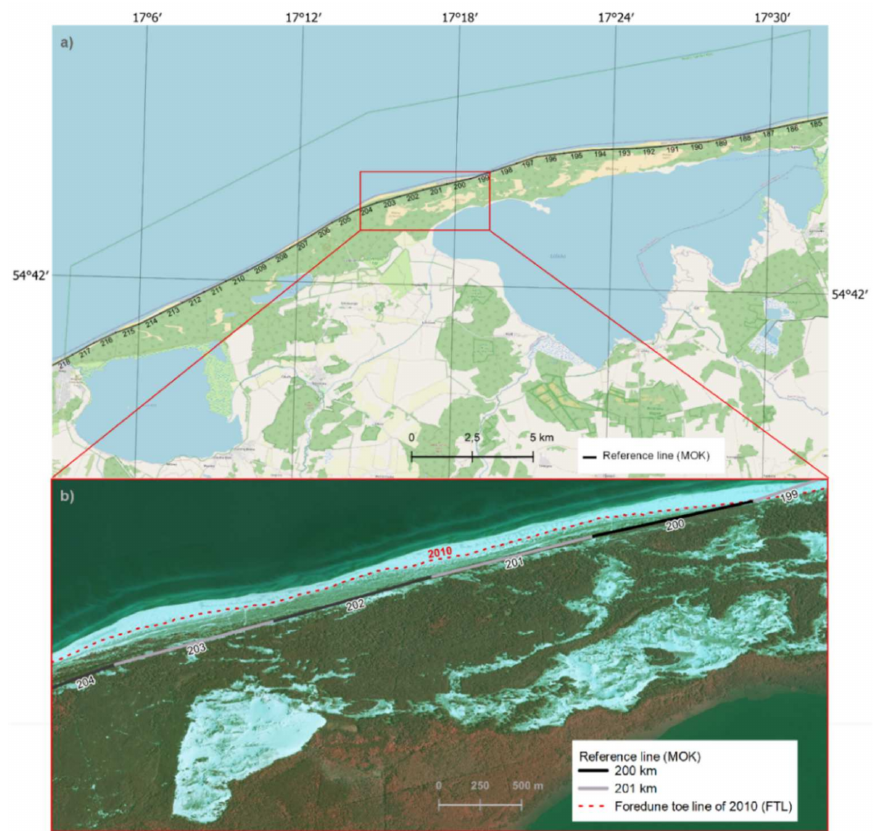
Figure 3. The route of the reference line (RL)—Polish Maritime Office’s Kilometer line (MOK), ( a ) along the examined coast section of the Baltic Sea, the base map—OpenStreetMap, ( b ) The routes of the selected part of RL and FTL line in year 2010 (red color)—the base map—orthophotomap dated 2010.